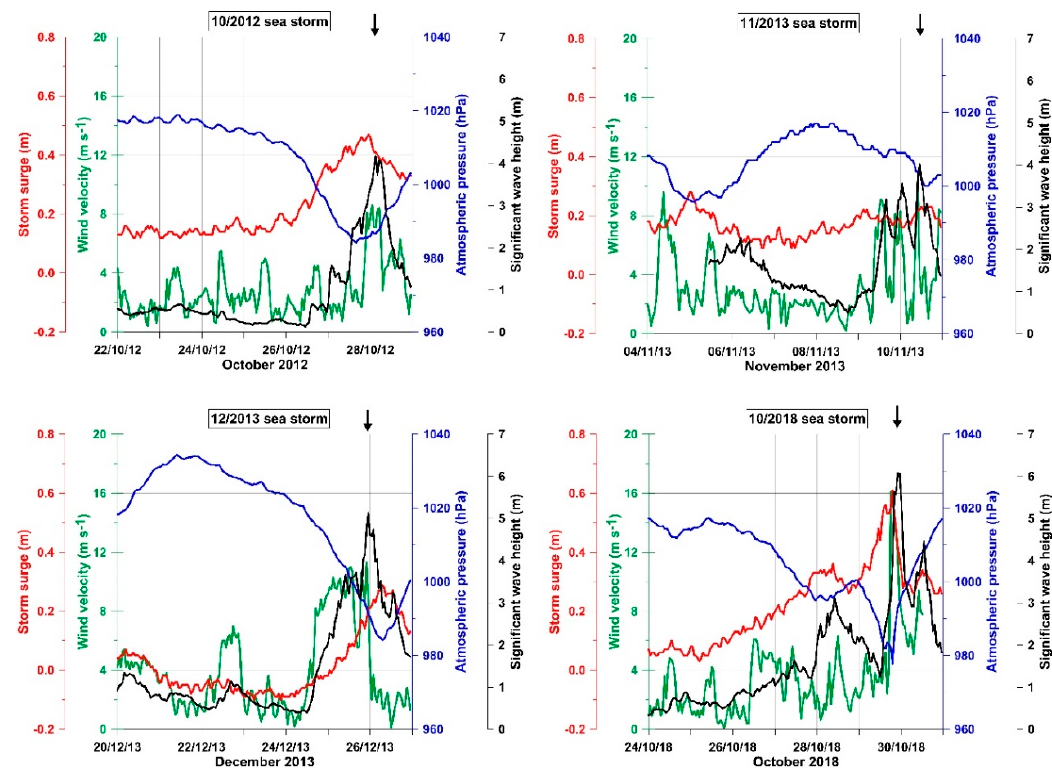
Figure 5. Storm surge (red lines), atmospheric pressure (blue lines), mean wind velocity (green lines) measured by the Imperia stations, and significant sea wave height (black lines) measured by the Capo Mele buoy. Black arrows indicate the time of the maximum sea wave height.